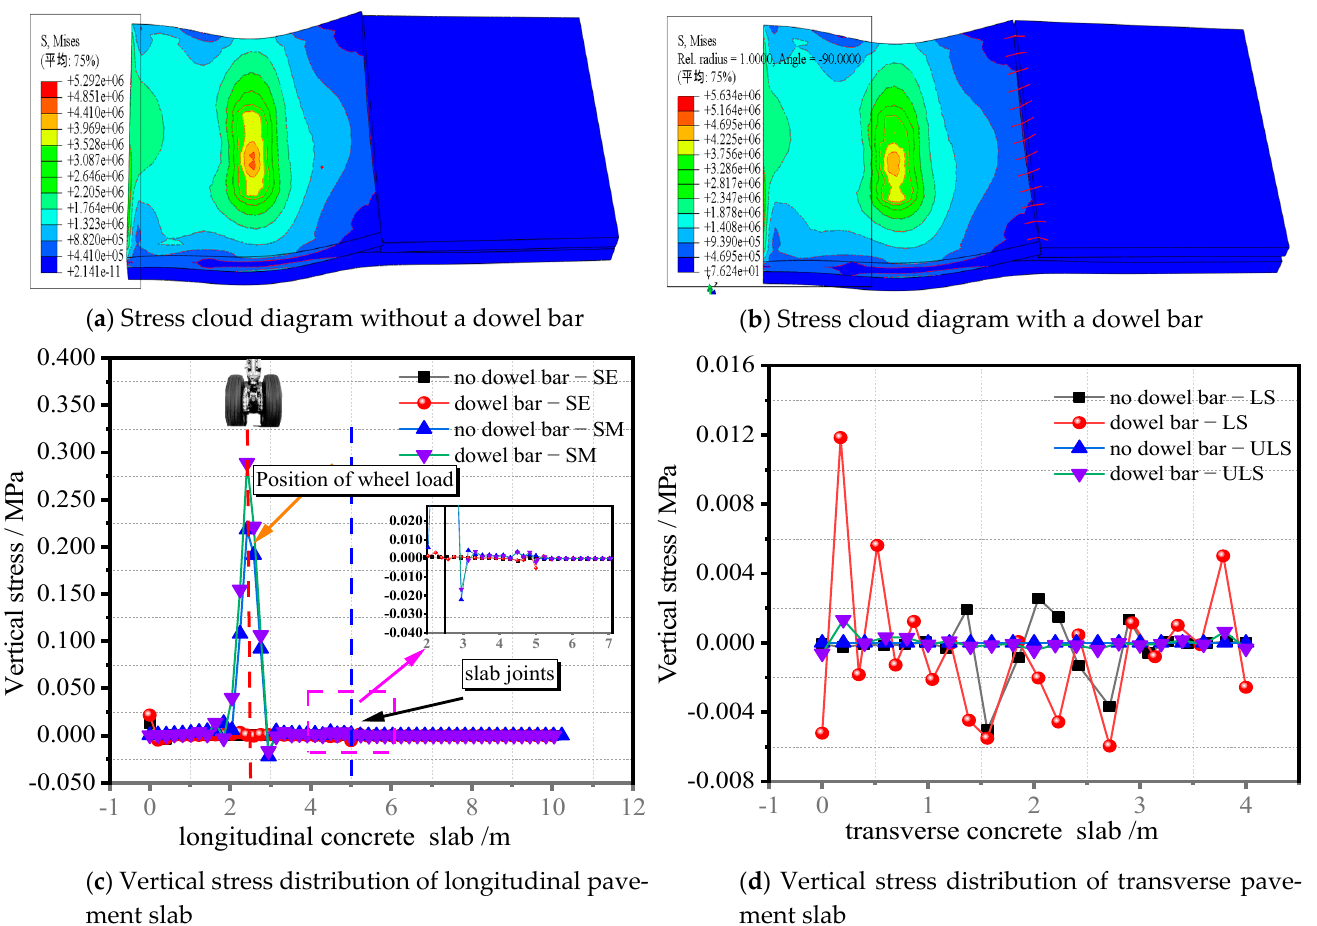
Figure 6. Stress distribution of pavement slabs under the aircraft’s wheel load. As depicted in Figure 7a,b, the displacement of the pavement slab progressively diminishes from the wheel load to the surrounding area, thus exhibiting a displacement diffusion circle, and the longitudinal and transverse displacement of the pavement slab decreases in a parabolic fashion. The slab’s vertical displacement at the longitudinal half of the laden slab, the slab’s edge, and the attenuation coefficient, are all affected when a wheel load is applied to it. These measurements are 1.06 mm, 0.25 mm, and 76.42%, respectively. The vertical displacement at the center of the laden slab’s longitudinal edge is 0.31 mm, whereas the edge of the slab is 0.17 mm. The attenuation coefficient is 45.16%. Here, in the transverse direction of the loaded slab, the vertical displacement between the wheel load and slab edge increases by 0.28 mm. Figure 7 shows that there is an upward warping deformation along the slab’s edge, and Figure 7c,d also demonstrate that there is an upward warping deformation at the joint between the adjacent slabs. The warping deformation displacement of the loaded slab’s edge is 0.28 mm, and that of the empty slab is 0.05 mm when there is no dowel bar. The displacement caused by warping when a dowel bar is present is 0.28 mm for the loaded slab’s edge and 0.15 mm for the unloaded slab’s edge. Hence, we may conclude that when the dowel bar is introduced, the adjacent slabs share a portion of the load, the deformation of the laden slab occurs on the opposite side, and the deflection load transfer coefficient of the dowel bar is